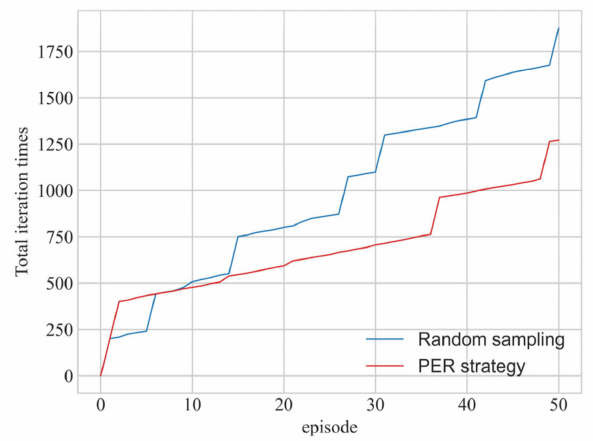
Figure 5. Comparison of the number of iterations before and after the introduction of prioritized experience replay (PER) strategy.